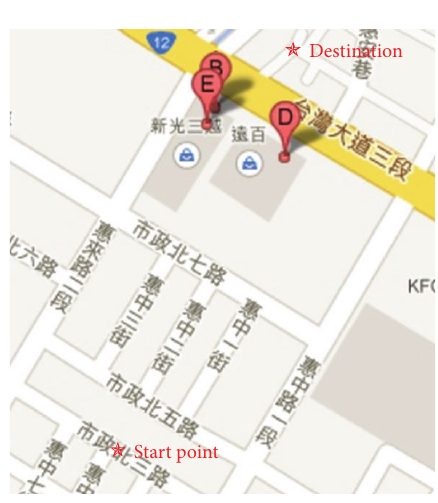
Figure 4: The experimental